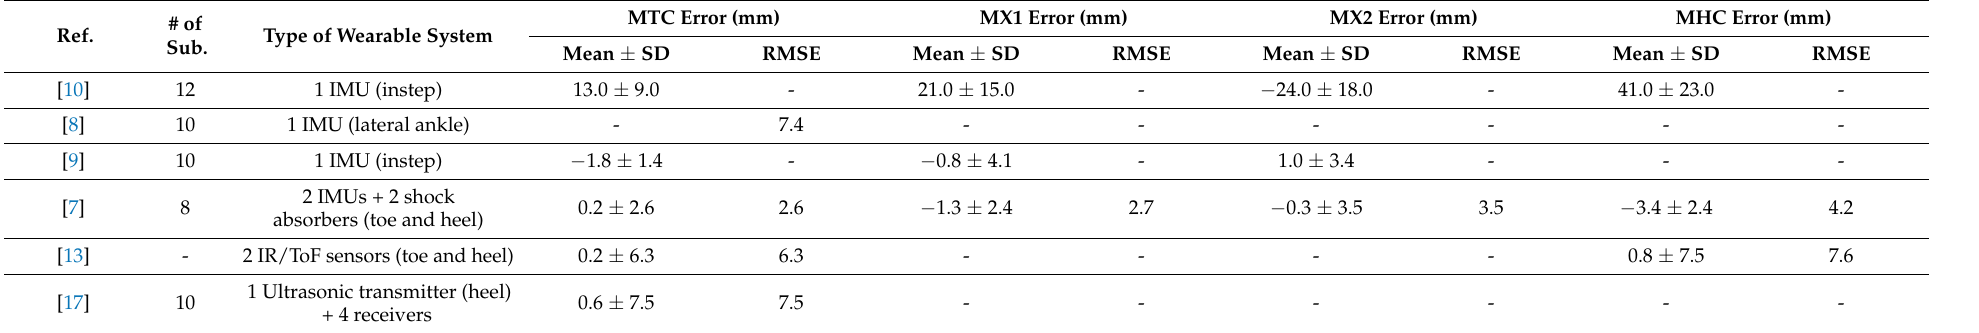
Table 1. Summary of the previous literature for wearable